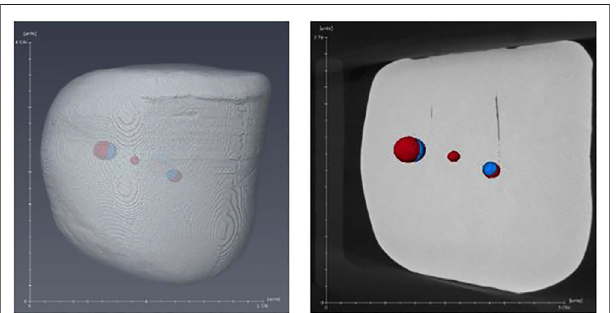
FIGURE 5 | showing a sample melted with the slow heating regime.